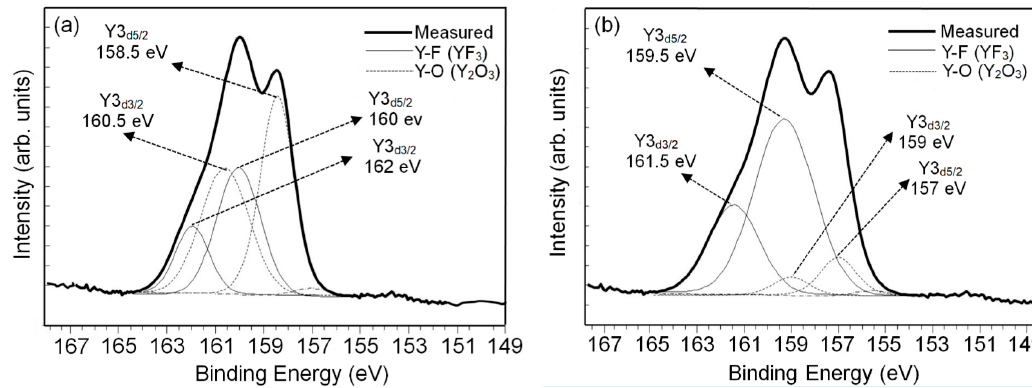
Figure 5. Variations of chemical compositions measured using XPS with the sputtering time of ( a ) the